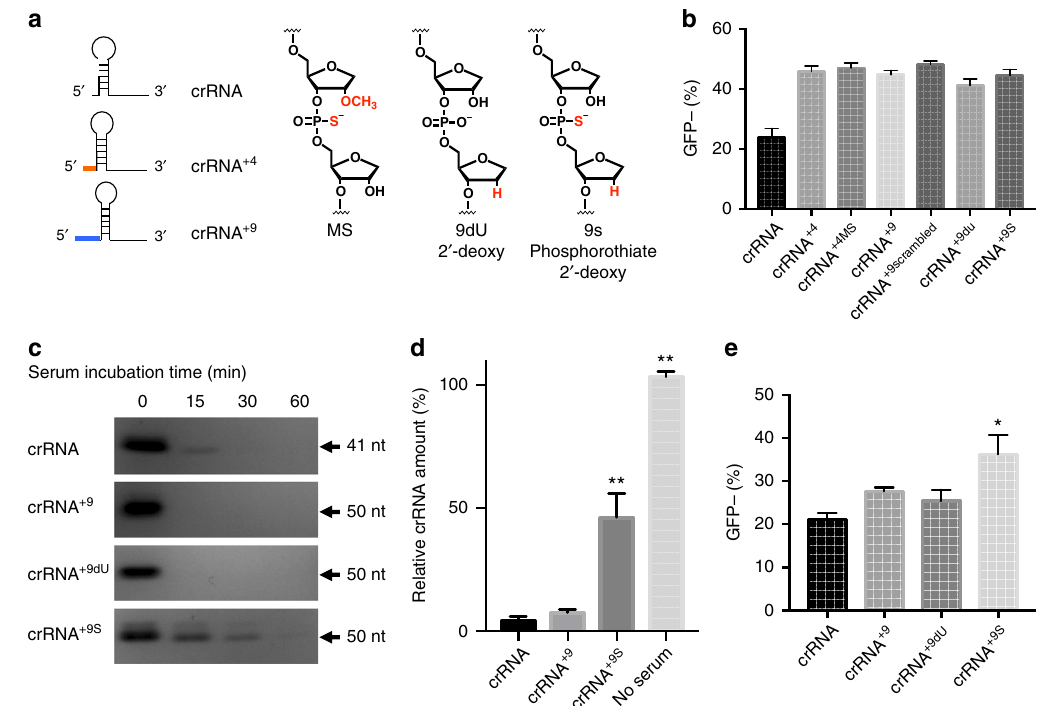
Fig. 5 Chemical modi fi cations on the 5 ′ extended crRNA are well tolerated and enhance serum stability. a crRNAs with 4 and 9 nt extensions, using a variety of sequences: MS is 2 ′ -OMe 3 ′ -phosphorothioate modi fi cations on the fi rst three nucleotides from the 5 ′ end, + 9dU is 2 ′ -deoxy modi fi cation on the 9th nucleotide from the 5 ′ end, + 9S is phosphorothioate modi fi cations on the fi rst 9 nucleotides from the 5 ′ end on top of 2 ′ -deoxy modi fi cation on the 9th nucleotide. b Chemical modi fi cations on extended crRNAs are well tolerated and show similar Cpf1 gene editing ef fi ciency to unmodi fi ed crRNAs in GFP- HEK cells. Mean ± SE, n = 3. All extended crRNAs had a statistically signi fi cant difference to unmodi fi ed crRNA with a p value less than 0.01 by Student's t test. c crRNA with phosphorothioate backbone modi fi cation (crRNA + 9S ) has enhanced serum stability. crRNAs with and without chemical modi fi cation were incubated with serum and analyzed by gel electrophoresis. d Quanti fi cation of crRNAs after 15 min incubation in serum. Relative band intensity of crRNA, normalized to crRNA without serum incubation. Mean ± SE, n = 3. ** p < 0.01 by Student ’ s t test compared to crRNA control. e crRNA with a 9 nt extension that has been modi fi ed with a phosphorothioate backbone (crRNA + 9 ) has enhanced Cpf1 gene editing ef fi ciency after delivery with Lipofectamine. Cpf1 RNPs with various crRNAs were delivered with Lipofectamine to GFP-HEK cells and the GFP-negative population was quanti fi ed. Mean ± SE, n = 3. * p < 0.05 by Student ’ s t test compared to crRNA